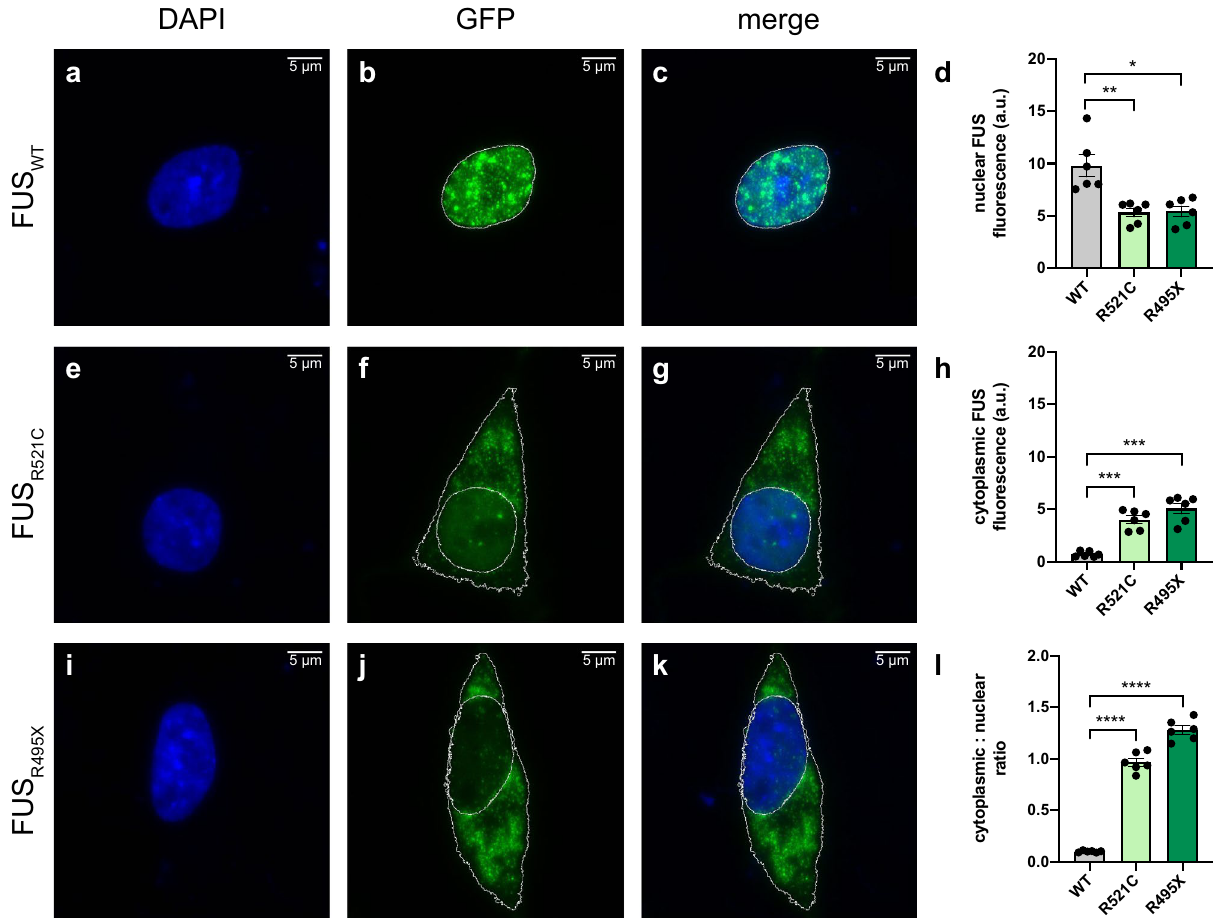
Figure 1. Detection of FUS cytoplasmic mislocalisation with exogenous expression of FUS mutations. Representative images of SH-SY5Y cells overexpressing GFP-tagged ( a – c ) FUS WT , ( e – g ) FUS R521C or ( i – k ) FUS R495X . Nuclei were visualised with DAPI (blue). ( d ) Quantification of the fluorescence intensity of the nucleus shows a significant reduction in nuclear FUS expression in cells expressing FUS R521C or FUS R495X , when compared to FUS WT . ( h ) Quantification of the fluorescence intensity of cytoplasmic FUS shows significantly higher cytoplasmic FUS expression in FUS R521C and FUS R495X , when compared to FUS WT . ( l ) Quantification of the cytoplasmic/nuclear ratio of exogenous FUS shows a marked increase in FUS R521C - and FUS R495X -expressing cells when compared to FUS WT . Scale bars = 5 μm. Data is represented as mean ± SEM. a.u. = arbitary units. *p < 0.05; **p < 0.01; ***p < 0.001; ****p < tical neurons by ~ 20% when compared to CYLD WT4 . When compared to GFP-only vector control (0.079 ± 0.001; Fig. 4a–d), expression of CYLD WT -GFP (Fig. 4e–h) in SH-SY5Y cells led to a significant 1.2-fold increase in the TDP-43 cytoplasmic/nuclear ratio (0.095 ± 0.001; p = 0.0002; Fig. 4q–s). In turn, expression of CYLD M719V -GFP (Fig. 4m–p) caused a further 1.3-fold increase in cytoplasmic/nuclear TDP-43 relative to CYLD WT -GFP (0.121 ± 0.002; p < 0.0001; Fig. 4q–s). The CYLD M719V mutation had the same effect in HEK293 cells, causing a 1.3-fold increase in the cytoplasmic/nuclear ratio relative to CYLD WT (0.145 ± 0.007; p = 0.0115; Supplementary Fig. S4). We also transfected cells with the CYLD D681G mutation (Fig. 4i–l and Supplementary Fig. S4) which is